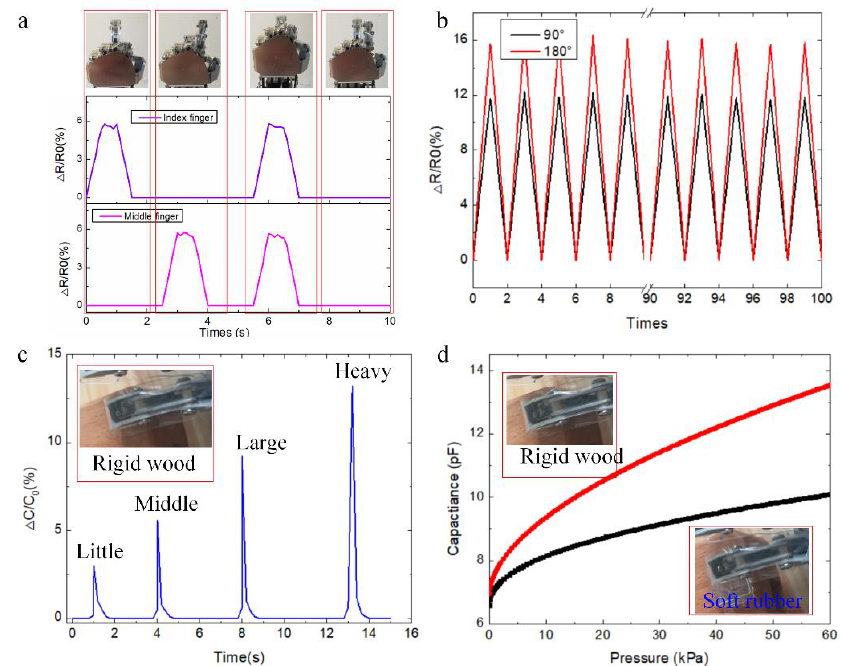
Figure 5. Demonstration experiments of RES for collecting motion data of robotic finger. ( a ) Typical strain data under different robot finger gestures. ( b ) Continuous strain data with repeated bending and releasing process. ( c ) Output capacitance of the pressure sensor with different loadings. ( d ) Pressure data is recorded when touching soft rubber and rigid wood.